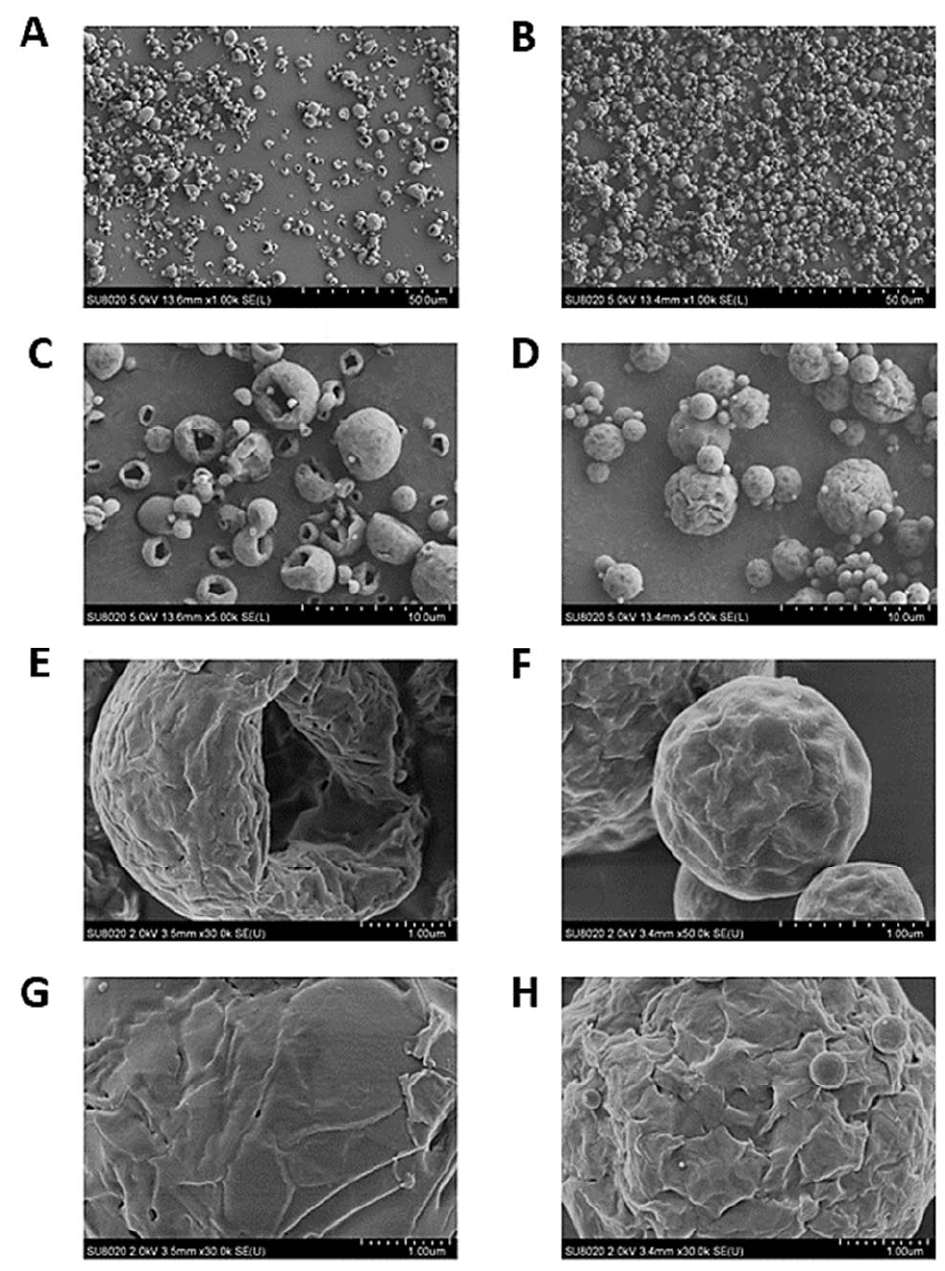
Figure 8. Representative scanning electronic micrographs of LUZ19 ( A , C , E , G ) and 14-1 ( B , D , F , H ) powders.